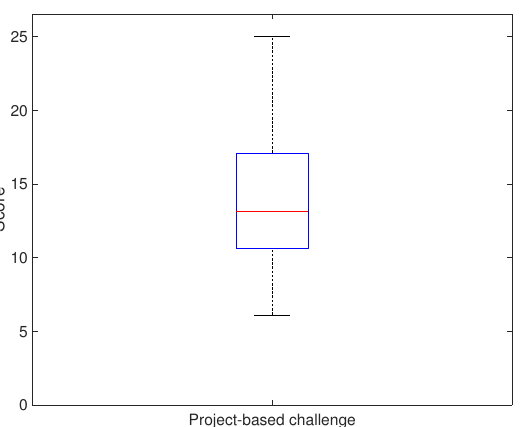
Figure 14. Evaluation results: final project (implementing an imaginary system to solve the real-world problem) scores (achievement